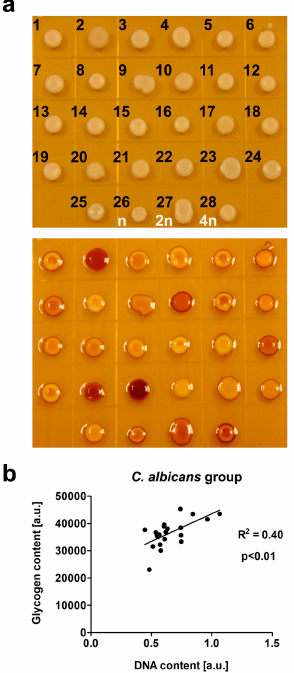
Figure 3. Examination of glycogen content by iodine staining ( a , lower panel). Unstained Candida cells (spots) are also presented for comparison ( a , upper panel). C. albicans group (1, 2, and 4–19), C. tropicalis group (20, 21), C. glabrata group (3 and 22–25), 302 haploid reference strain (26), SC5314 diploid strain (27), and T15 tetraploid strain (28). ( b ) Correlation analysis between glycogen content [a.u.] and DNA content [a.u.] within C. albicans group is shown. Correlation analysis of the data was performed using a linear correlation (Pearson r) test. The R 2 value is shown.